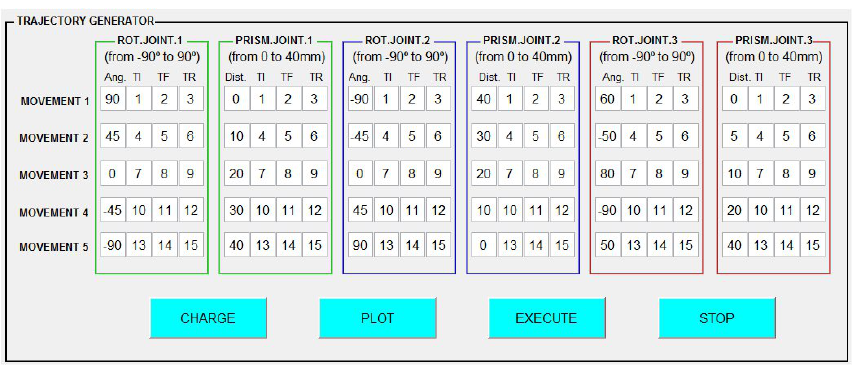
Figure 8. GUIDE for programming